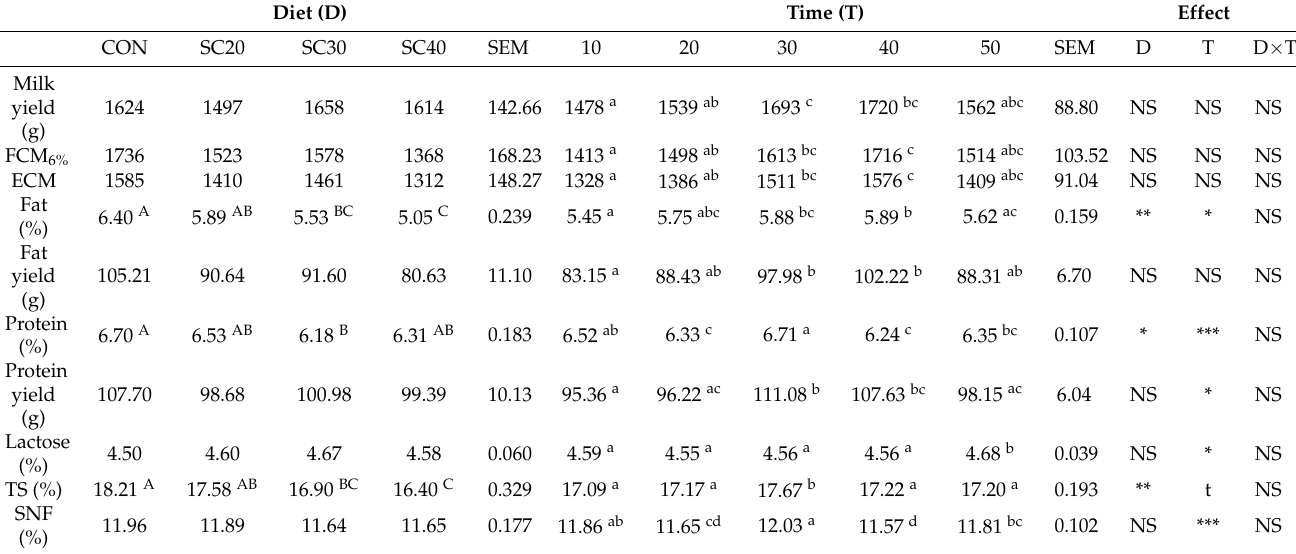
Table 2. Milk yield and milk chemical composition of ewes fed diets (CON, SC20, SC30, SC40) with different levels of Schizochytrium spp. microalgae (20, 30 and 40 g) throughout the experimental period (10, 20, 30, 40, 50 experimental